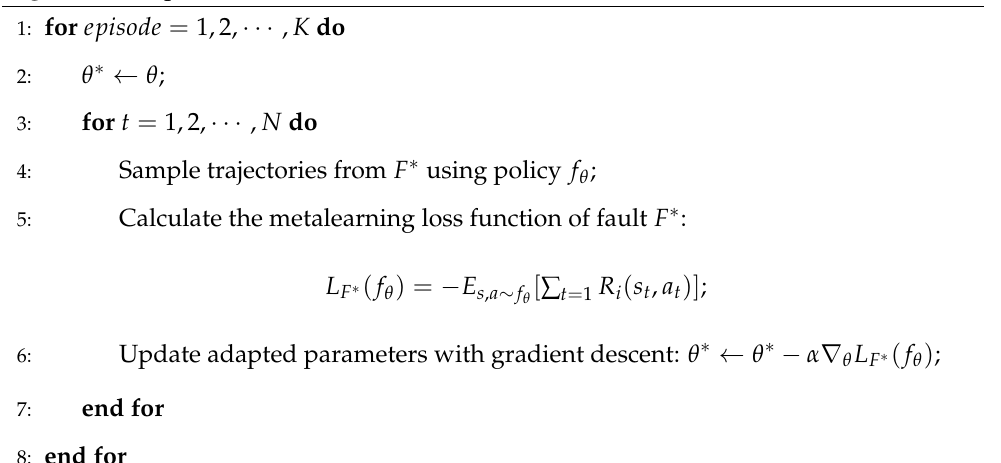
Algorithm 2 Update of the metatrained